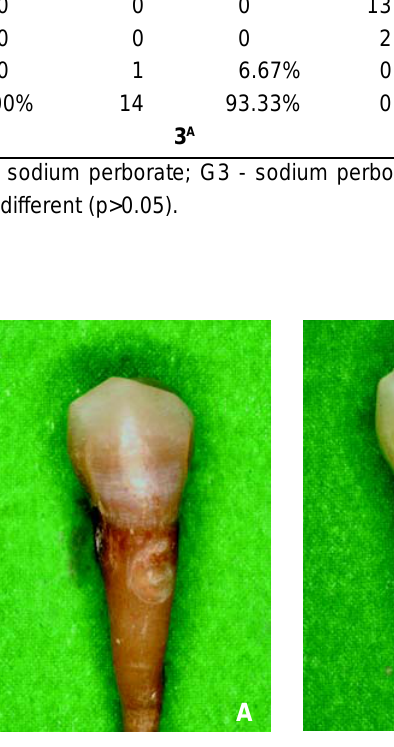
FIGURE 2- Specimen representative of group G1 after discoloration (A) and after 21 days of bleaching (B) with